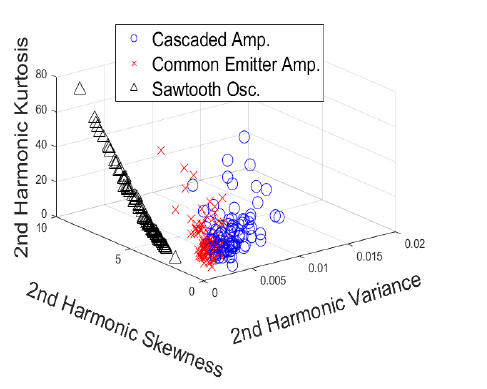
Version June 4, 2022 submitted to Remote Sens. 11 of 19